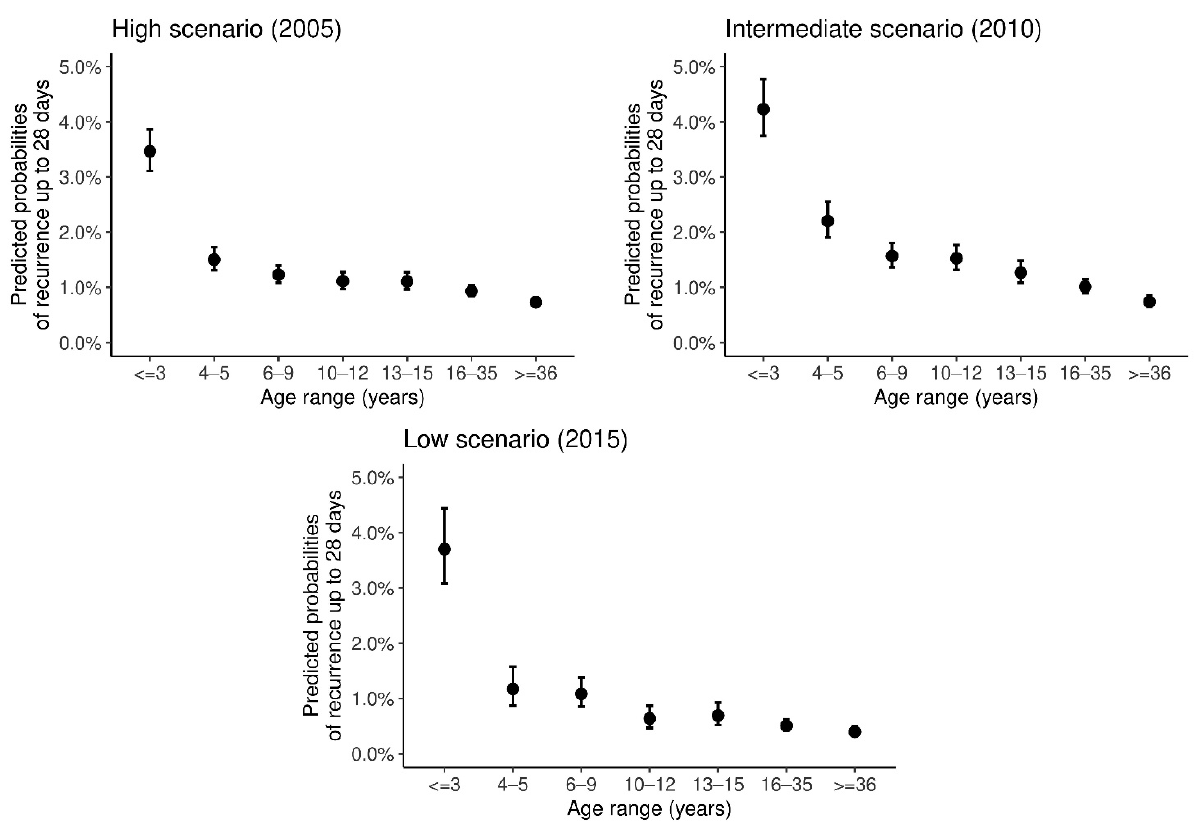
Figure 4. Predicted probability of recurrence up to 28 days according to age group in the Brazilian Amazon in 2005, 2010, and 2015. Bars represent 95% confidence interval for the predicted probabilities.